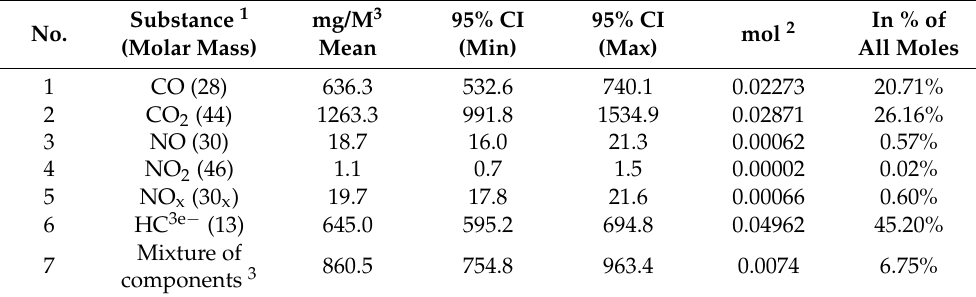
Table 2. Average values of the chemical composition of tobacco smoke, in terms of M 3 and mol of radicals, respectively